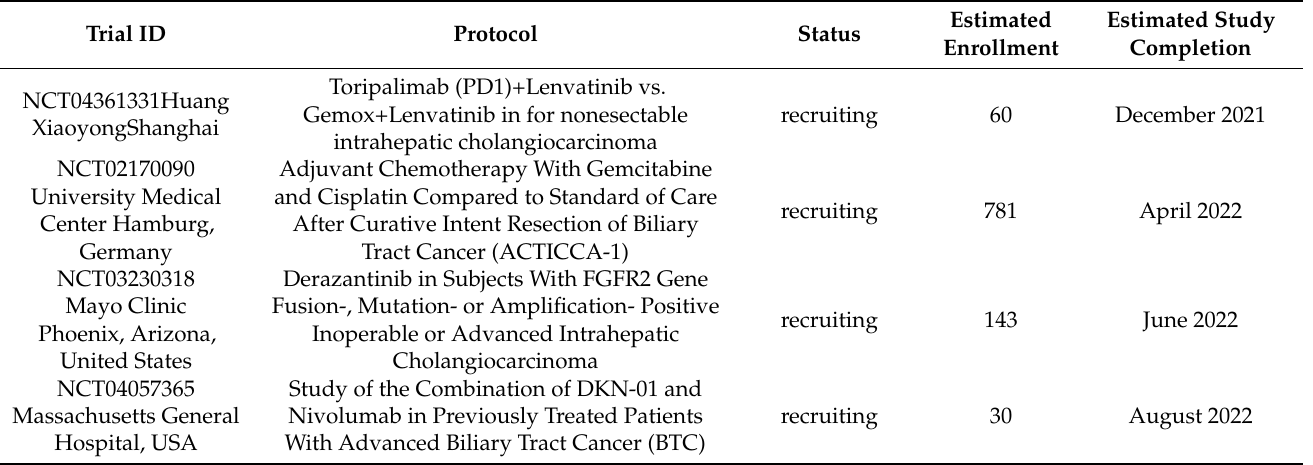
Table 2. Ongoing trials for adjuvant and neoadjuvant